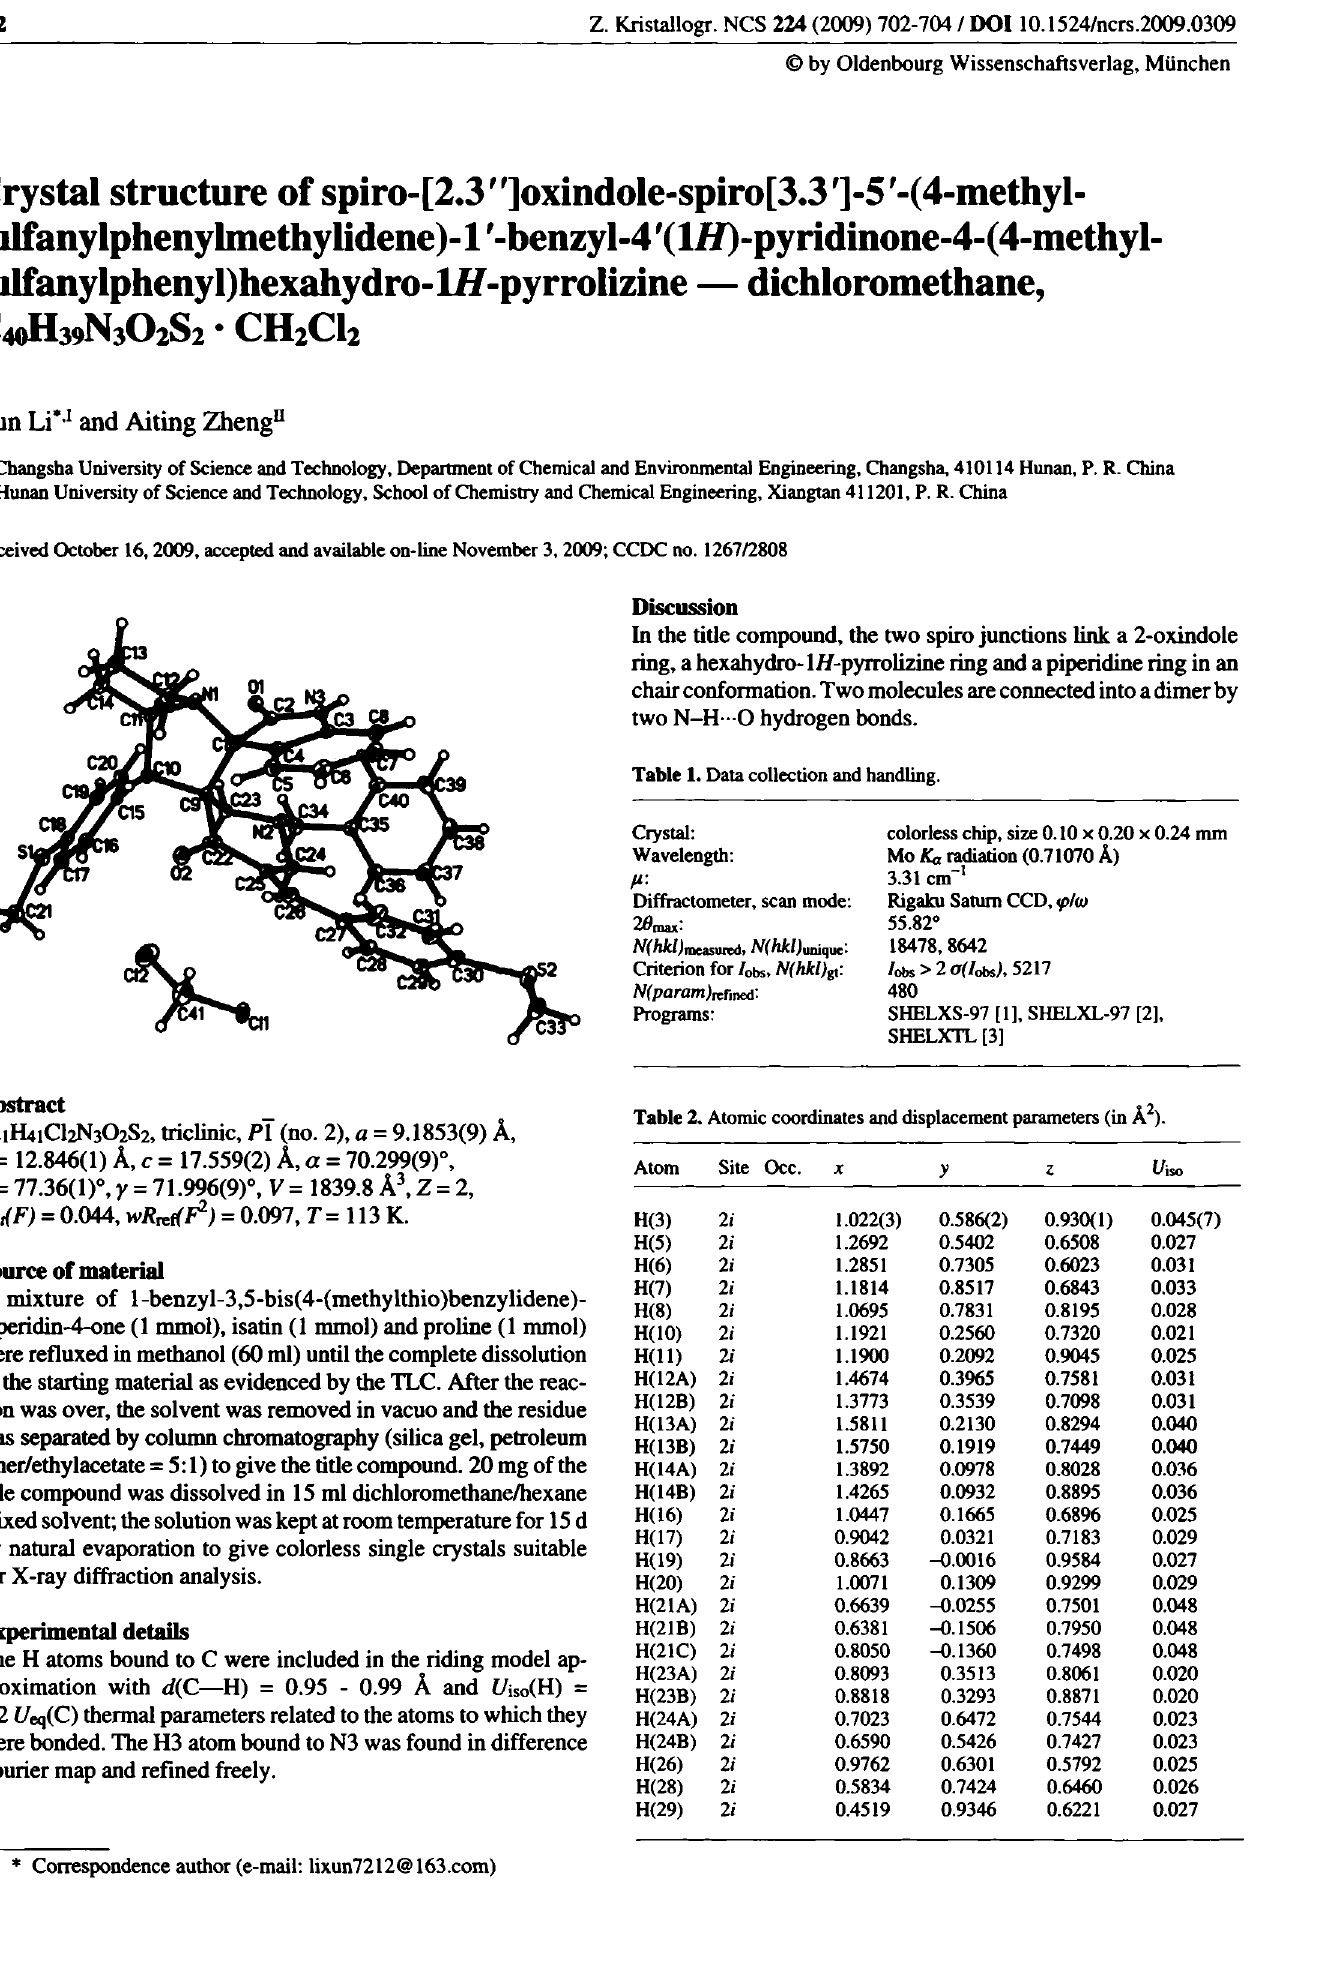
Table 1. Data collection and handling.